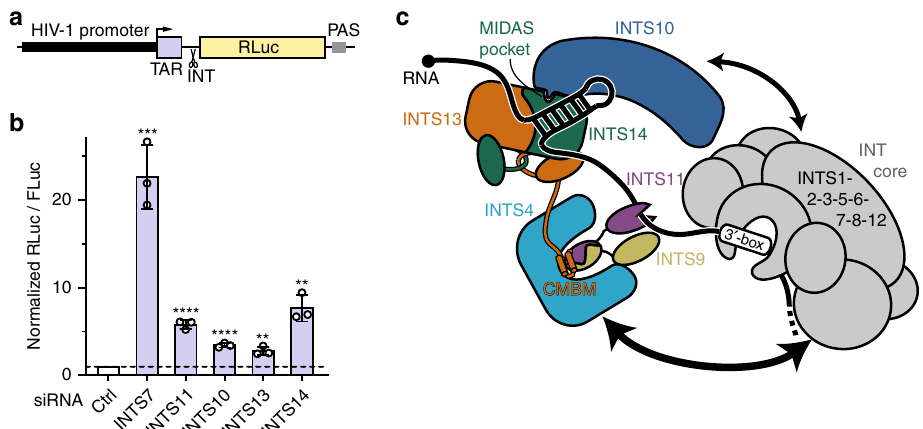
Fig. 7 INTS10 – 13 – 14 are required for termination after pausing. a Scheme of the RNAPII pause-termination reporter used in b . Reduced RNAPII pausing and termination at the HIV-1 TAR element results in elongation and increased RLuc levels. b Luciferase assay using the TAR pause-termination reporter. Cells depleted of individual INT subunits were transfected with the TAR reporter and FLuc transfection control plasmid. Statistical signi fi cance was determined for each knockdown condition relative to control. Bars show mean values of biological triplicates together with the individual replicates as dots. Error bars represent standard deviations. Statistical signi fi cance was determined by unpaired, two-tailed t -test: not signi fi cant (ns) p ≥ 0.05; signi fi cant * p ≤ 0.05, ** p ≤ 0.01, *** p ≤ 0.001, **** p ≤ 0.0001. Western blots in Fig. 6a. Source data are provided as a Source Data fi le. c Summary model of INT modules and their respective protein interaction networks. INTS10 – INTS13 – INTS14 brings cleavage module and target RNA into